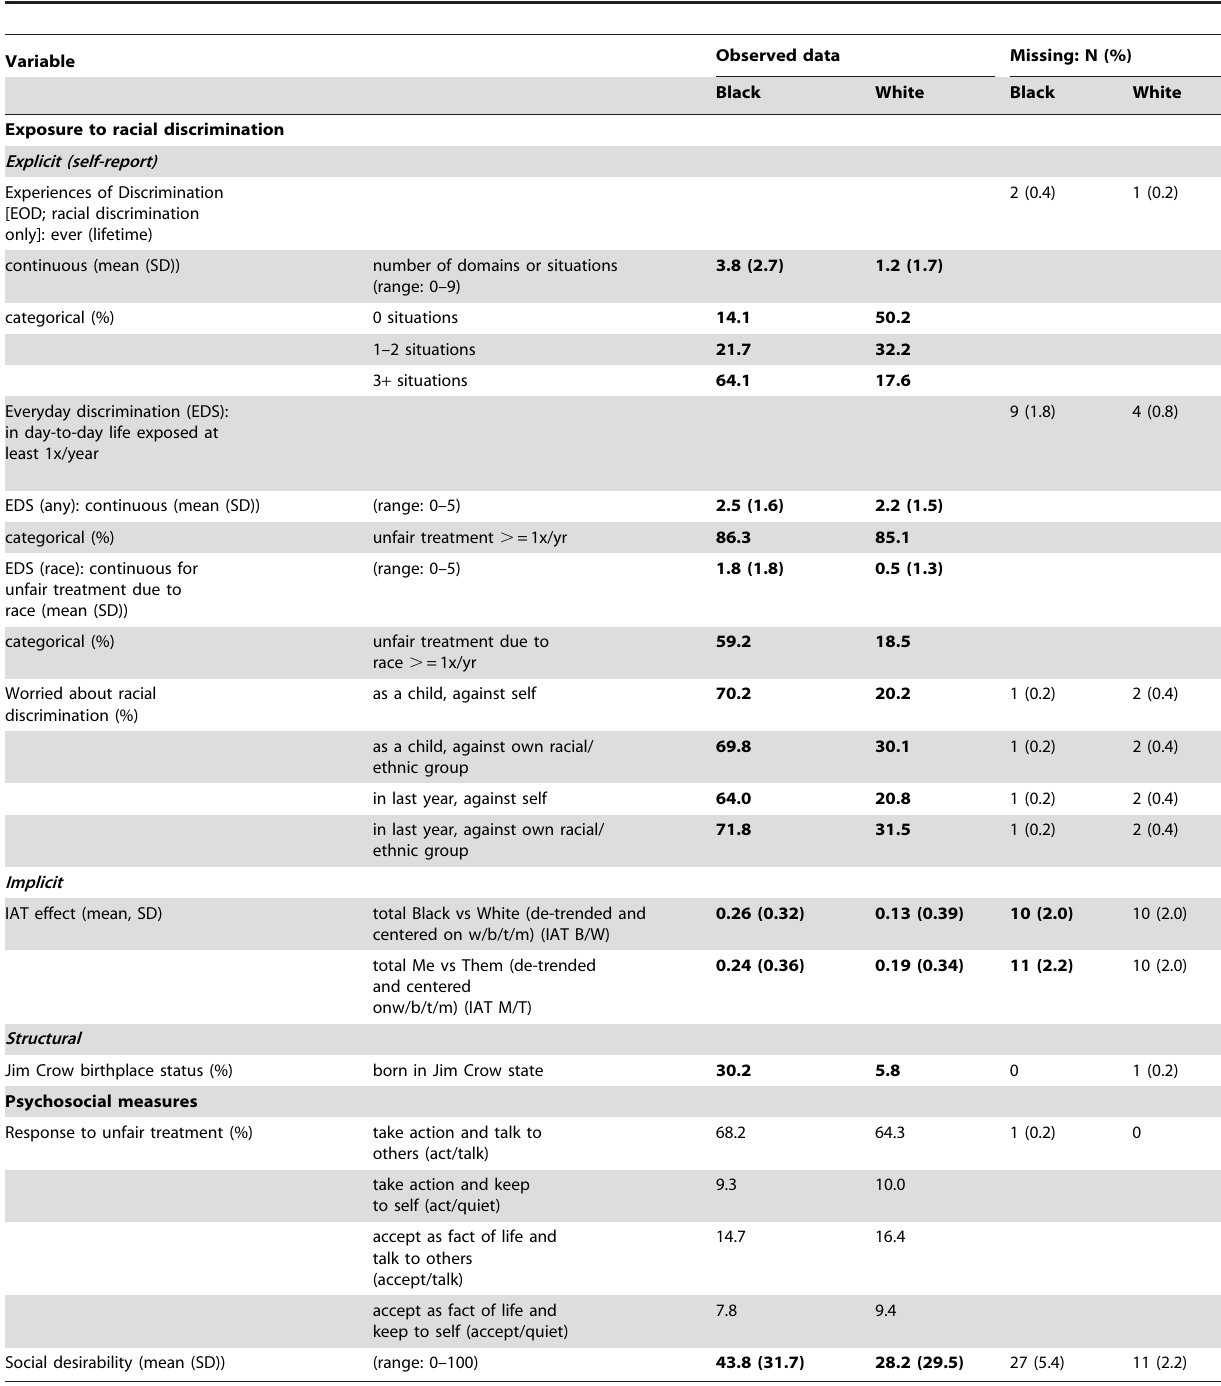
Table 2. My Body My Story study participants’ exposure to racial discrimination and psychosocial characteristics: 504 black and 501 white community health center members, all US-born, non-Hispanic, ages 35–64 (Boston, MA, 2008–2010).